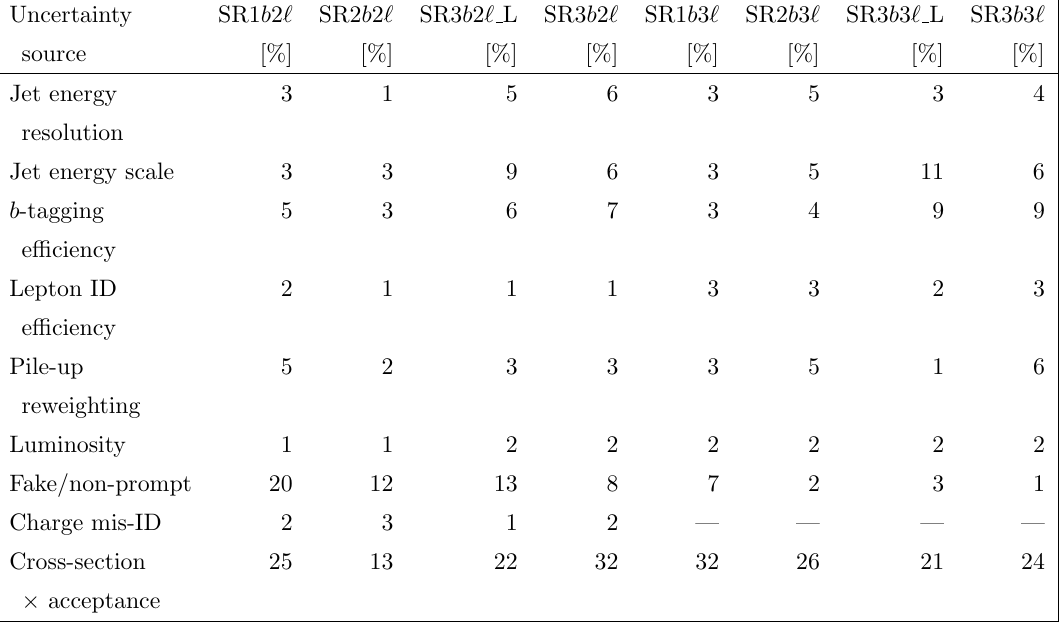
Table 8 . Uncertainty of the total background yields in the signal regions for the four-top-quark and VLQ searches due to the leading sources of systematic